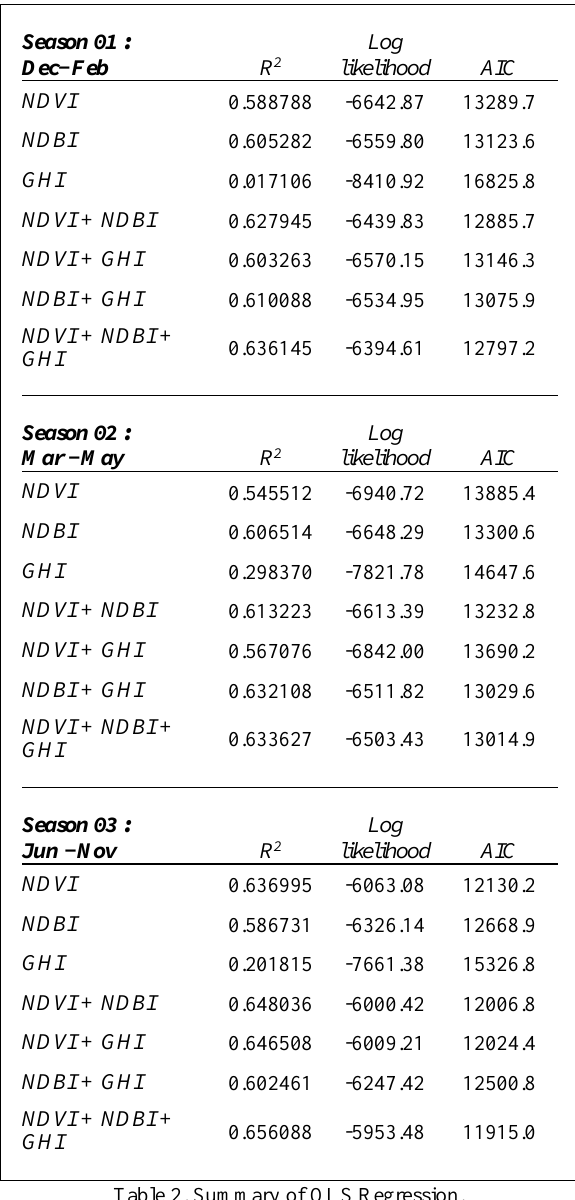
Table 2. Summary of OLS